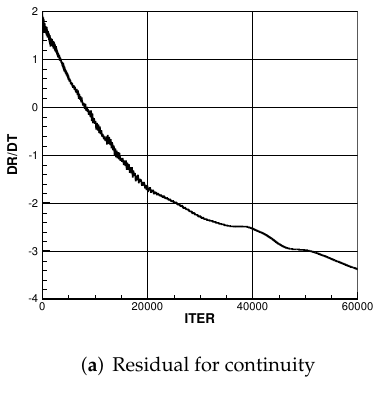
Figure 3. Convergence